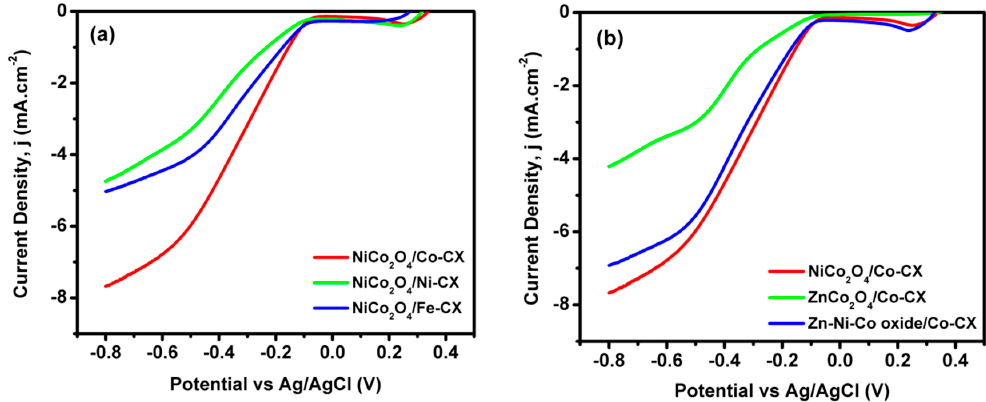
Figure 6. Cyclic voltammograms (CV) of ( a ) Zn–Ni–Co/Co–CX in both nitrogen and oxygen saturated electrolyte, ( b ) NiCo 2 O 4 /M–CX and ( c ) NiCo 2 O 4 /Co–CX, ZnCo 2 O 4 /Co–CX, Zn–Ni–Co/Co–CX in oxygen saturated electrolyte.